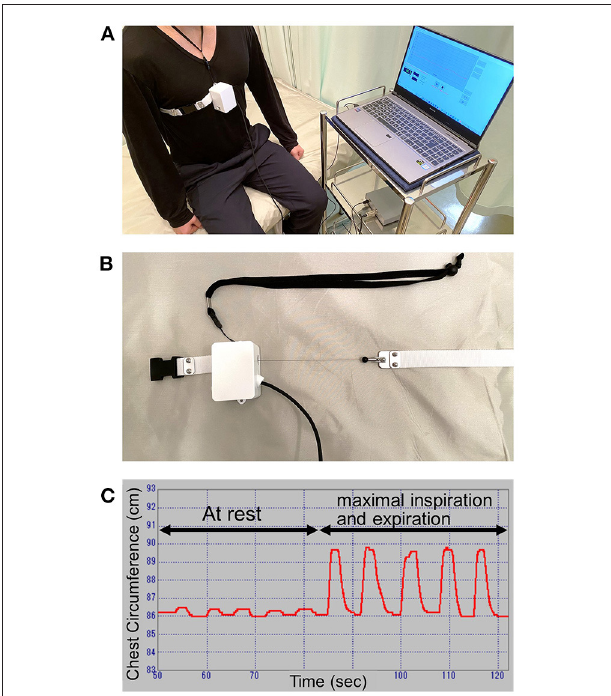
FIGURE 1 | Thoracic excursion measurement. (A) The scenery of thoracic excursion measurement. (B) The wire of the measurement device. (C) The display of the